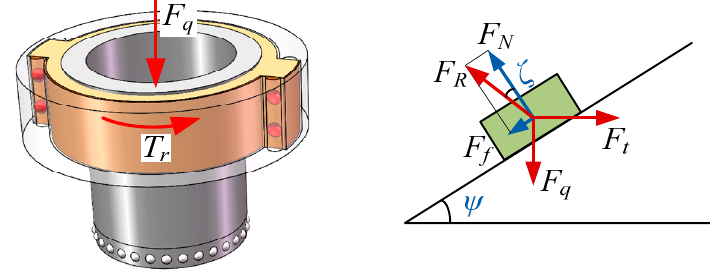
Figure 7. Force diagram of the screw drive mechanism.